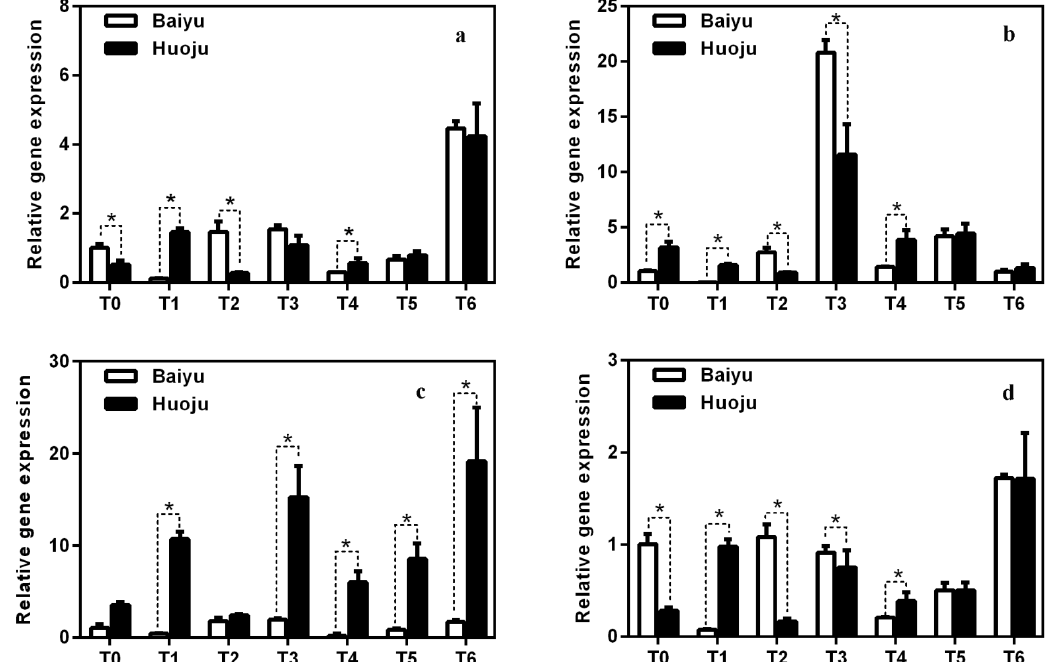
Figure 8. EjPYL4 ( a ), EjPYL4-like ( b ), EjPYL8 ( c ), and EjABI5-like ( d ) expression during loquat bud differentiation. Note: T0–T6 in horizontal axis indicates sampling dates, i.e., 7–13, 7–19, 7–27, 8–03, 8–10, 8–17, and 8–24, respectively; * indicates significance at p ≤ 0.05; bars indicate standard error.